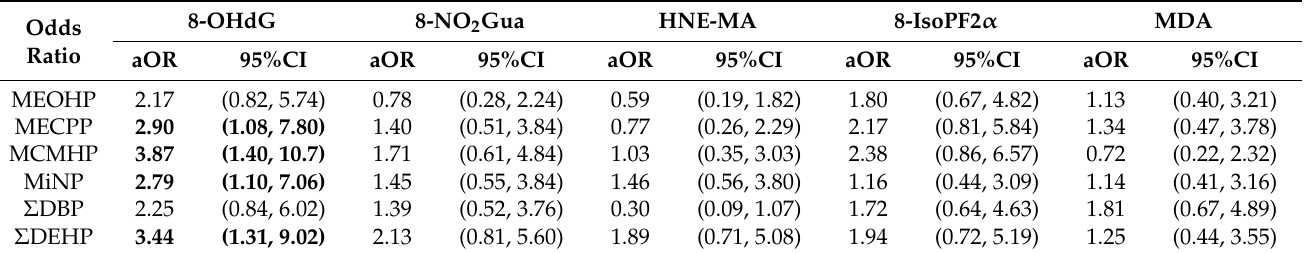
Table 6. Adjusted odds ratio for high oxidative/nitrosative stress biomarkers in the different urinary phthalate metabolite level (75th percentile) Table 6. Cont.